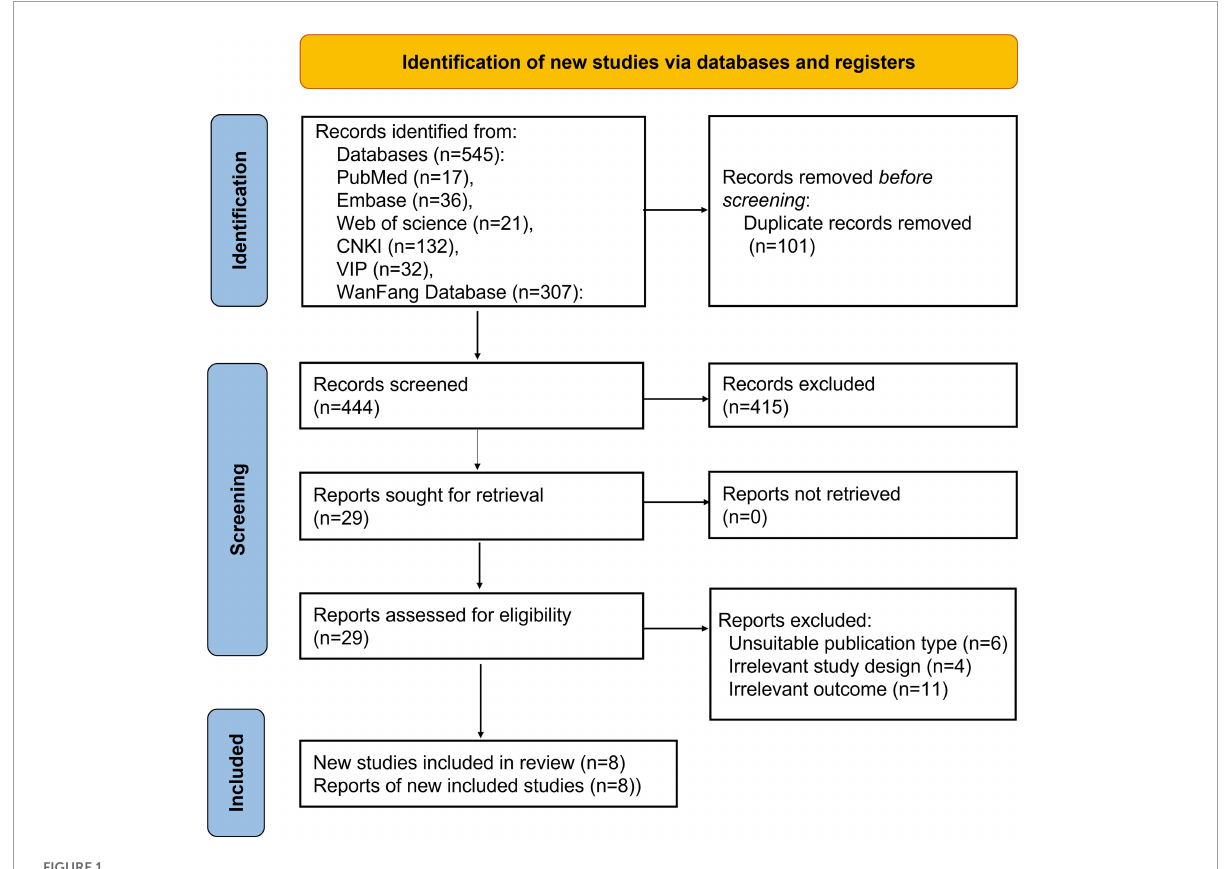
FIGURE1 Flow chart of eight studies